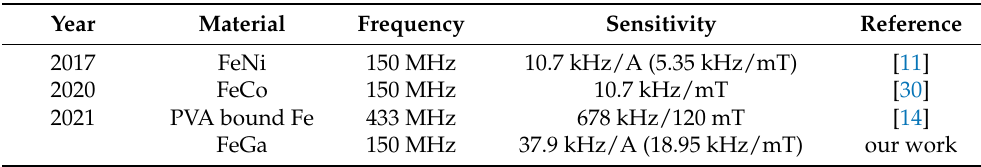
Table 2. The sensing performance comparison of the proposed sensor in this work with the existing sensor prototype with similar